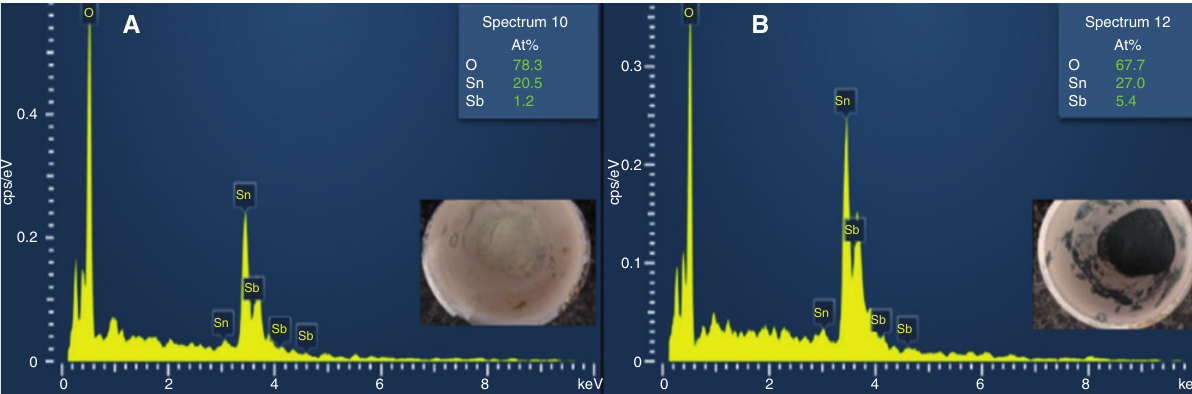
Figure 4: Energy dispersive X-ray spectroscopy (EDX) spectra of as-synthesized antimony-doped tin oxide (ATO) nanoparticles (NPs) with (A) 3% Sb and (B) 15%